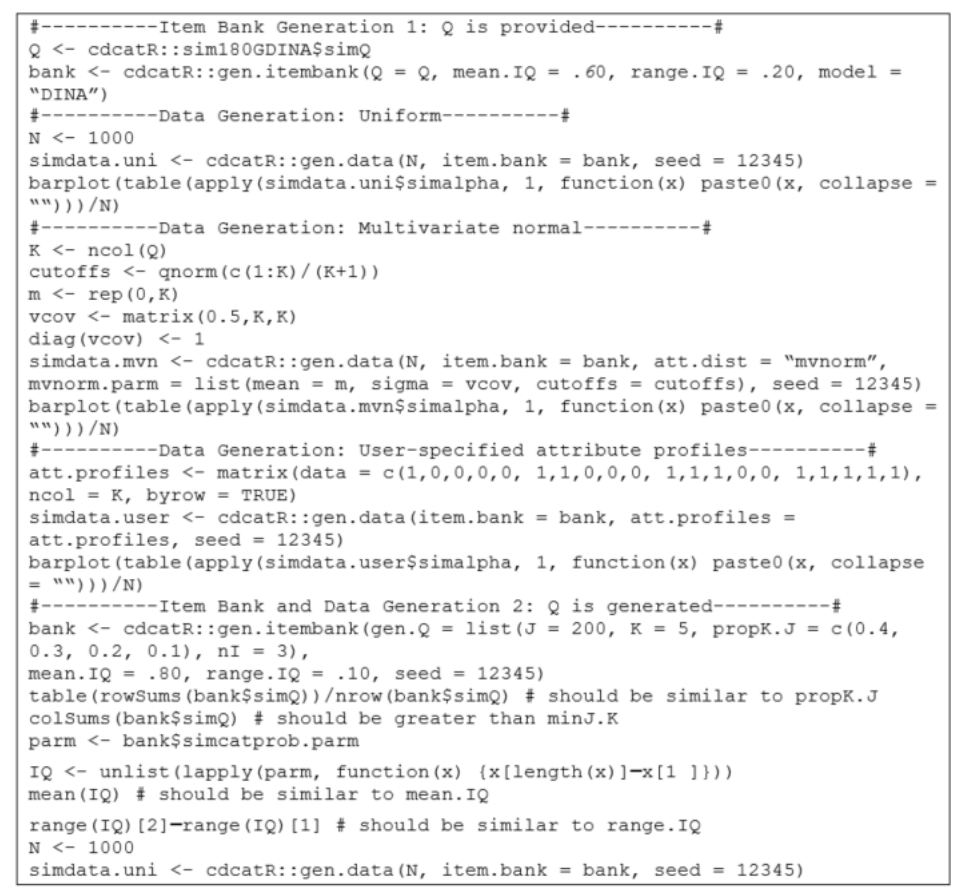
Figure 5. Illustration of how the gen.itembank() and gen.data() functions can be used to generate CDM data.